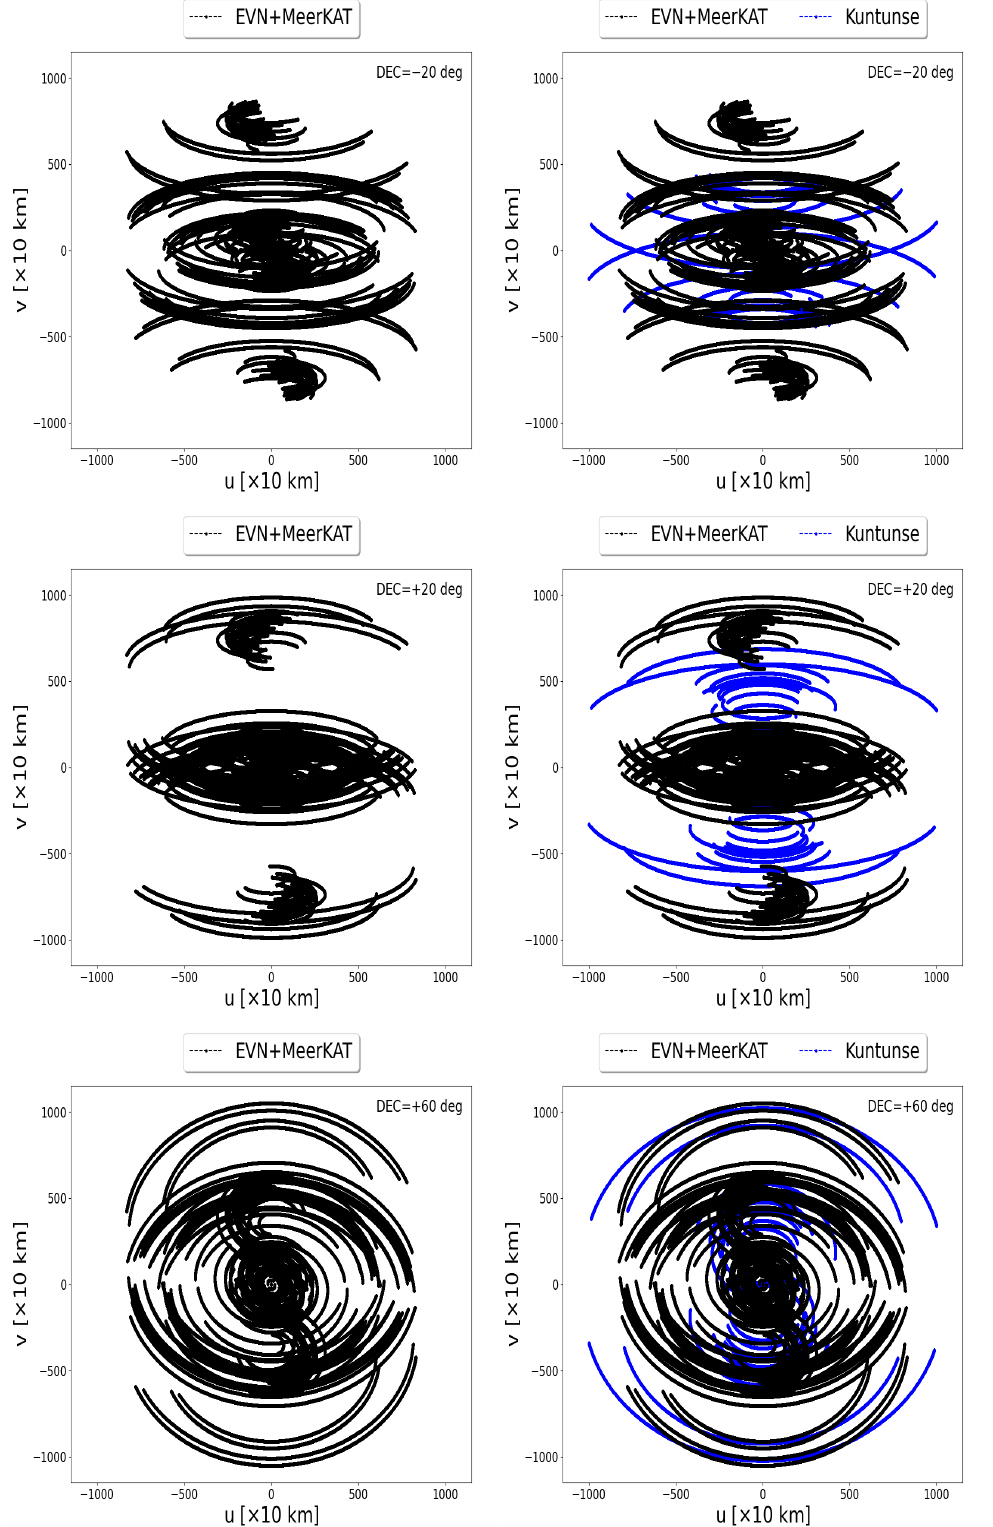
Figure 3. The EVN combined with the MeerKAT telescope (left panels) and the EVN combined with the MeerKAT telescope and the Kuntunse antenna in Ghana (right